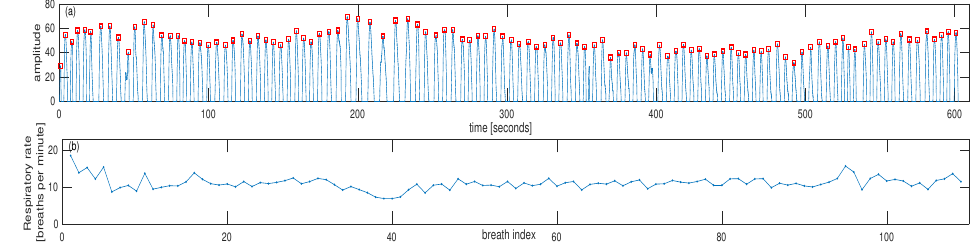
Figure 6. ( a ) The generated signal using thermocouple from subject #3, each pulse is related to one breath. ( b ) Estimated individual breaths using the timing between pulse peaks. There is one main episode of low breathing for this subject. The pulse peaks are noted by red squares in the top